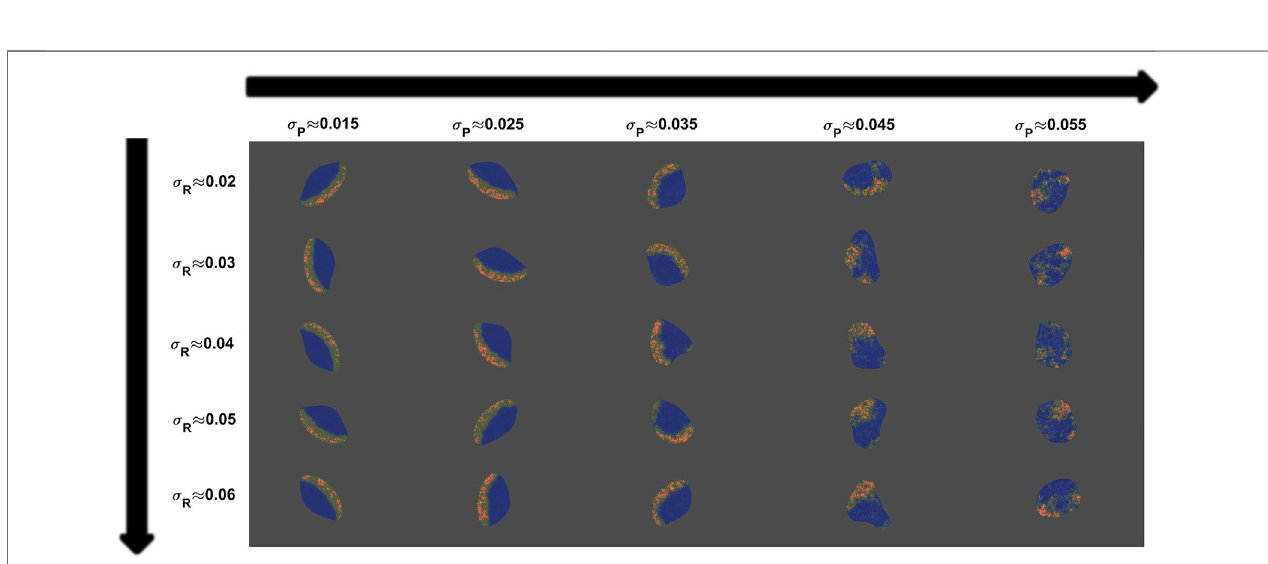
FIGURE6| Map ofsnapshots ofthevirtualcelltakenfromdifferentvaluesof k 14 and k 18 forthenewmass-conserved model. Foreach column,snapshots indicate P distribution (red) inside the cell. Variances of noise intensity were fi xed at σ R = 0.04 and σ P = 0.025. The rest of them are consistent with Supplementary Table S1 .